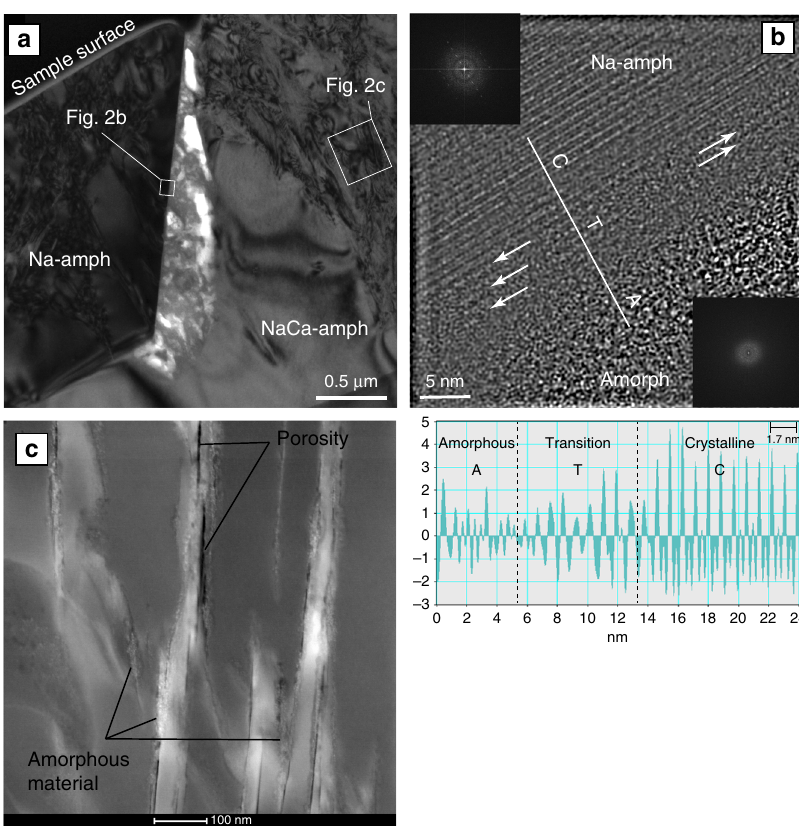
Fig. 2 Details of the FIB section across the NaCa-amph – Na-amph reaction zone. a Bright- fi eld TEM image of the reaction zone in Fig. 1b showing the syn- reactive pore space (white areas) fi lled with an amorphous material resulting from the dissolution of the sodic-calcic amphibole. b Lattice fringe image of the sodic amphibole surface showing the formation of re-polymerized silicate chains from the amorphous phase (Amorph) at the crystal surface. The intensity pro fi le along the white line demonstrates the formation of crystalline sodic amphibole directly from the amorphous material. c High-angle annular dark- fi eld (HAADF) TEM image of the dislocation-rich area in a showing the initial formation of the amorphous material and porosity along dislocation lines